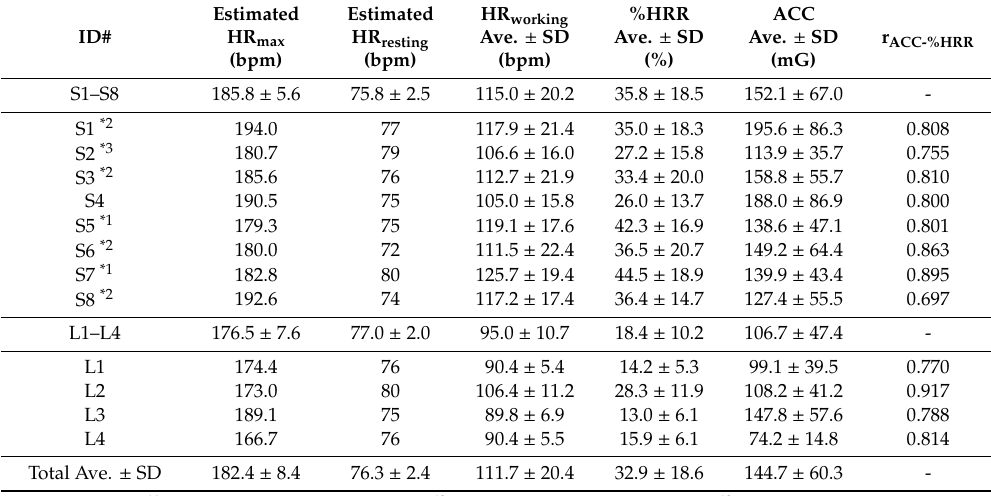
Table 5. Overview of subjects’ physical workload